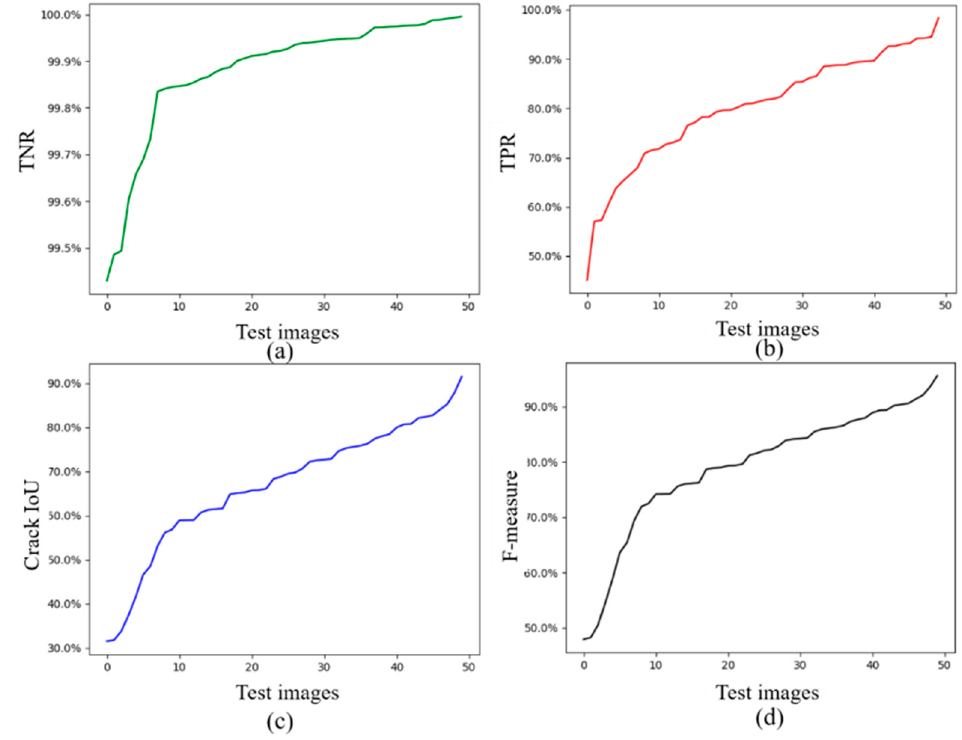
Figure 11. Indicator results of 50 testing images. ( a ) TNR, ( b ) TPR, ( c ) Crack IoU, ( d ) F-measure.